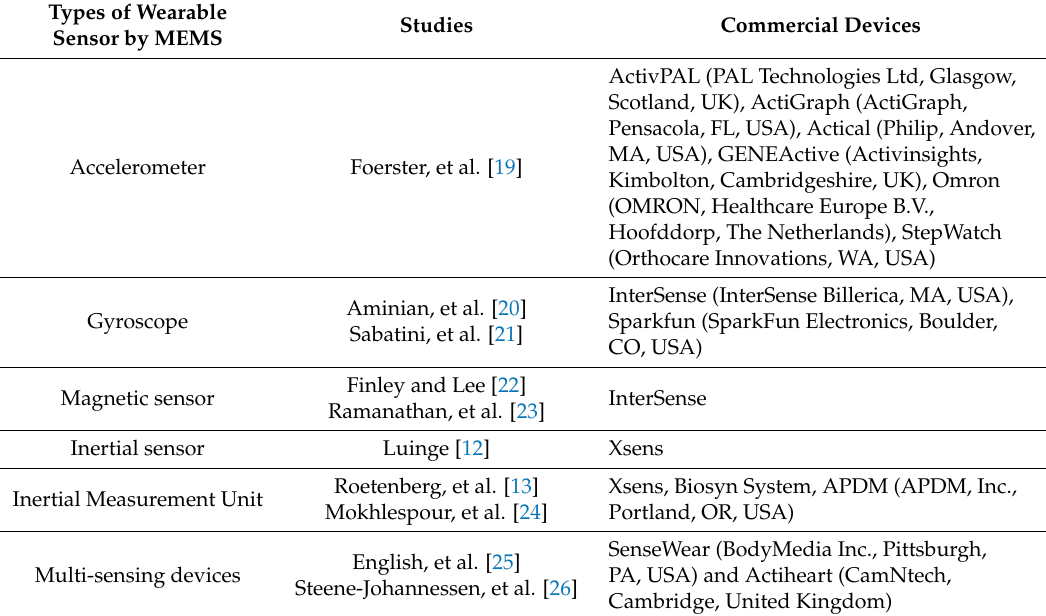
Table 1. Diverse types of MEMS-based wearable sensors developed to measure human